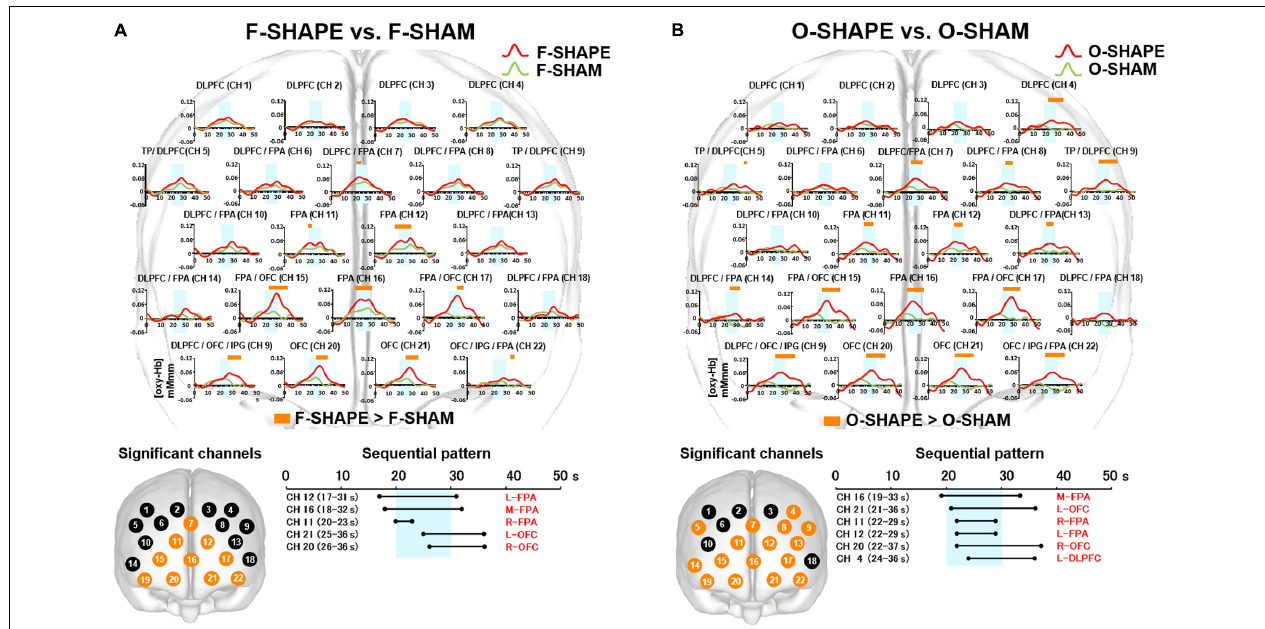
FIGURE 5 | Prefrontal functional near-infrared spectroscopy (fNIRS) activities in SHAPE as compared to SHAM. (A) Temporal differences and sequential pattern of prefrontal fNIRS activities in F-SHAPE as compared to F-SHAM. Prefrontal activations presented significant (two-way repeated measures ANOVA and Bonferroni t -test: p < 0.05) in the frontopolar area (FPA) and orbitofrontal cortex (OFC) during F-SHAPE as compared to F-SHAM. A sequential pattern of significantly shifting features in the onset and burst was noted from the FPA to the OFC during F-SHAPE as compared to F-SHAM. (B) Temporal differences and sequential pattern of the prefrontal fNIRS activities in O-SHAPE as compared to O-SHAM. Most channels presented significant (two-way repeated measures ANOVA and Bonferroni t -test: p < 0.05) prefrontal activation in O-SHAPE as compared to O-SHAM. A sequential pattern of significant (two-way repeated measures ANOVA and Bonferroni t -test: p < 0.05) prefrontal activation resulted in temporally overlapped features in the onset and burst of the DLPFC/FPA/OFC activities during O-SHAPE as compared to